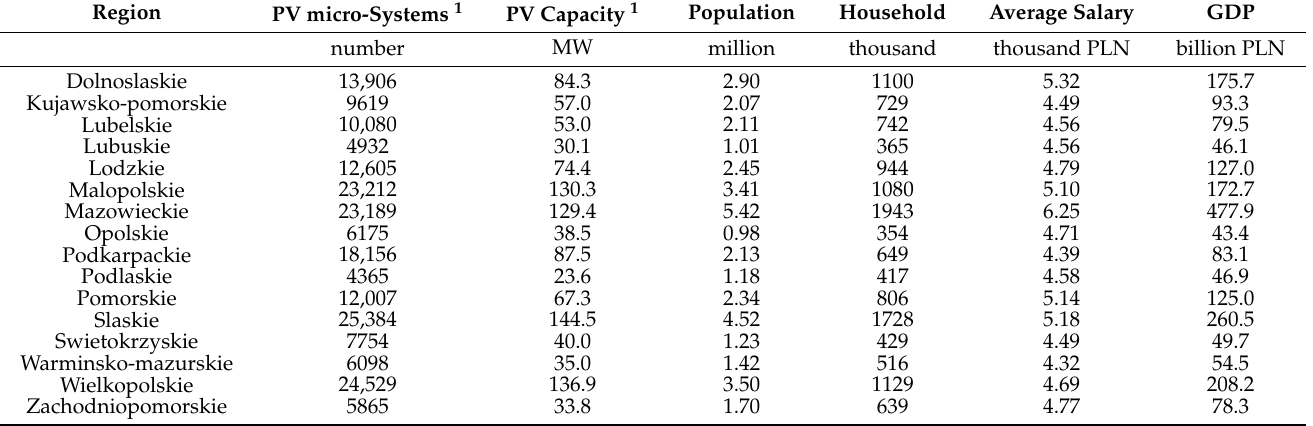
Table 1. The number of micro photovoltaic installations, photovoltaic capacity and the main features of the regions of Poland.